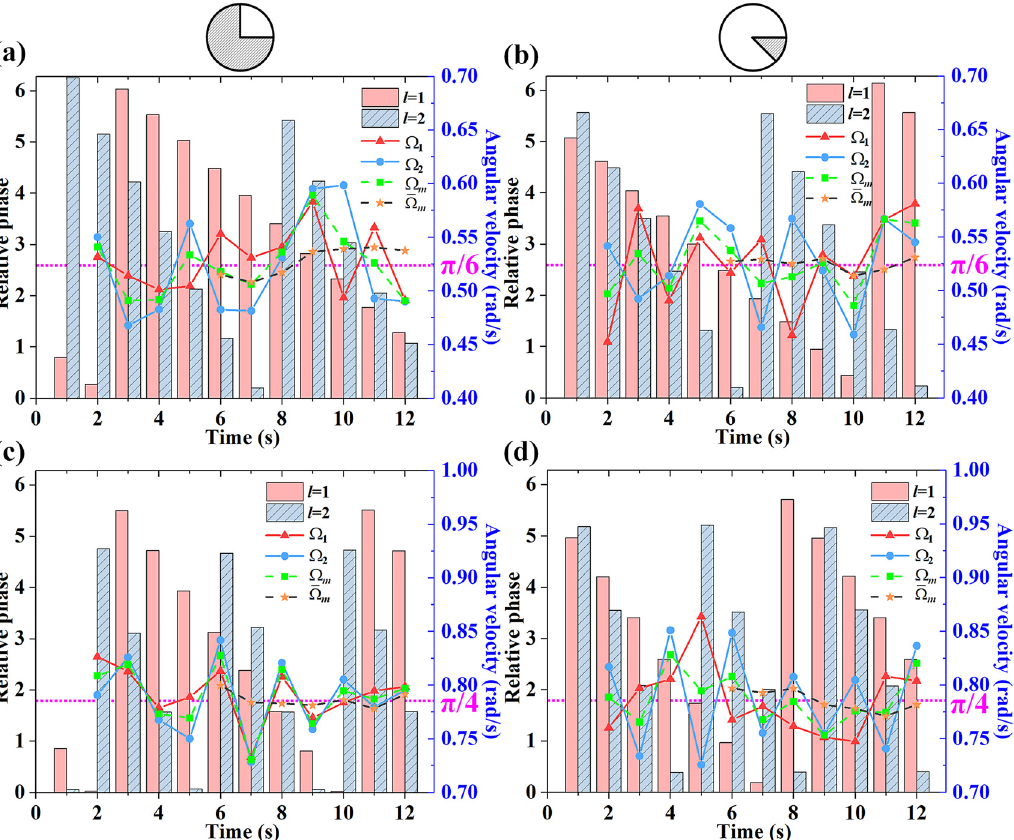
Figure 5: Detecting angular velocity using OAM phase spectra. (a)Theopeningangleandangularvelocityoftheobjectare π /2and π /6(rad/s),respectively.(b)Theopeningangleandangularvelocityofthe objectare7 π /4and π /6 (rad/s),respectively.(c)The openingangleandangularvelocity oftheobjectare π /2 and π /4(rad/s),respectively.(d) The opening angle and angular velocity of the object are 7 π /4 and π /4 (rad/s),